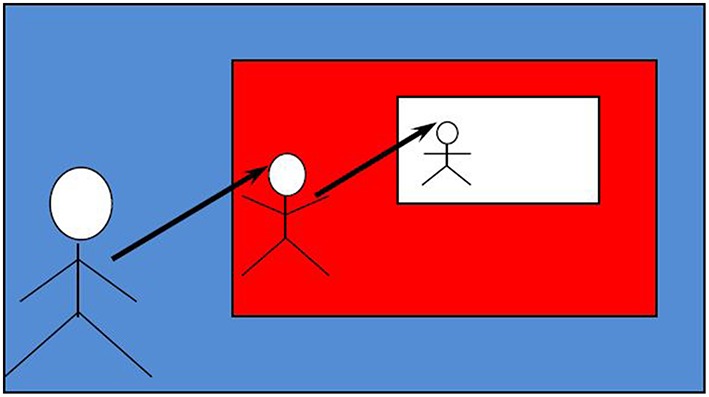
The parallel between theory-of-mind embeddings and syntactic structural embeddings (Sauerland, 2005).